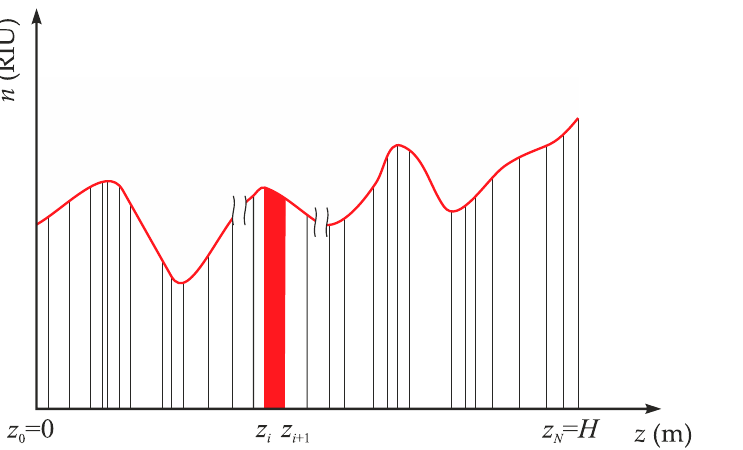
Figure 2. Scheme of a layered structure of a substance with an arbitrary dependence of the refractive index over its thickness.